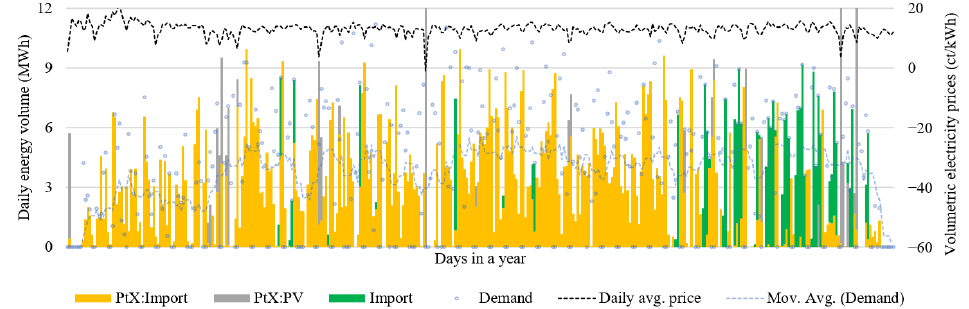
Figure 10. Daily hydrogen demand, supply and average electricity